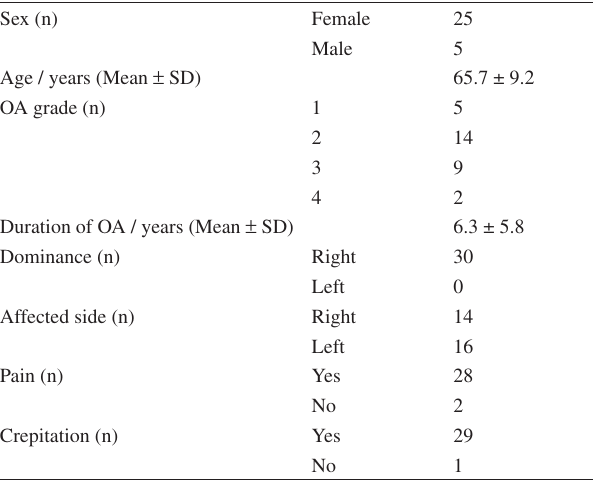
Table 1 - Clinical characteristics of patients with knee